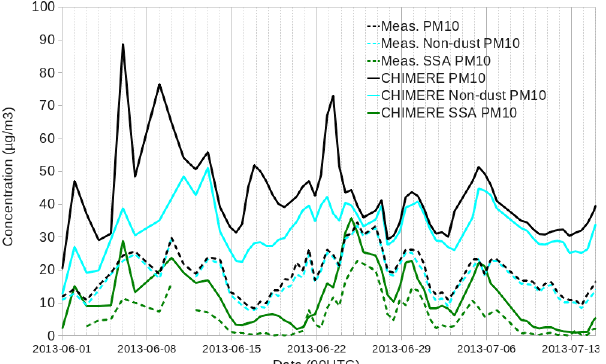
Figure 10. Modelled speciation of PM 10 aerosols in the first model layer compared to measurements for total PM 10 (black lines), non- dust PM 10 (blue lines) and sea-salt aerosols (green